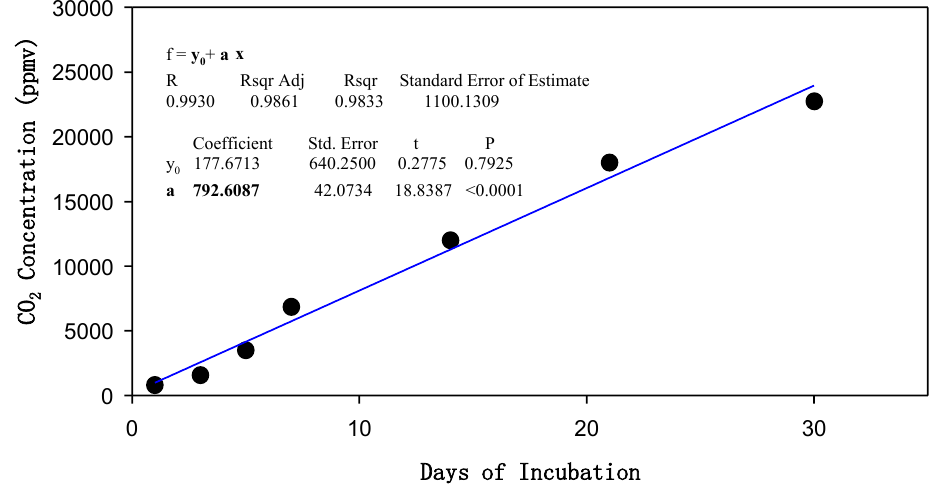
Figure 3. Example of the CO 2 accumulation in the headspace of a sample vial over the 30 day incubation period. The slope calculation is shown on the figure, which corresponds to a rate of 792.6 ppmv CO 2 day −1 and by using Equation (6) a mass based production rate of 10.2 μg -C g −1 day −1